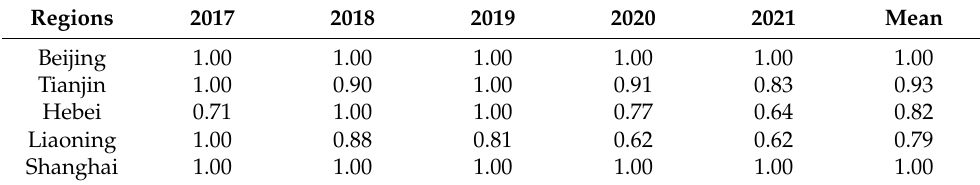
Table 5. Scale efficiency implementation management of green buildings during 2017–2021.